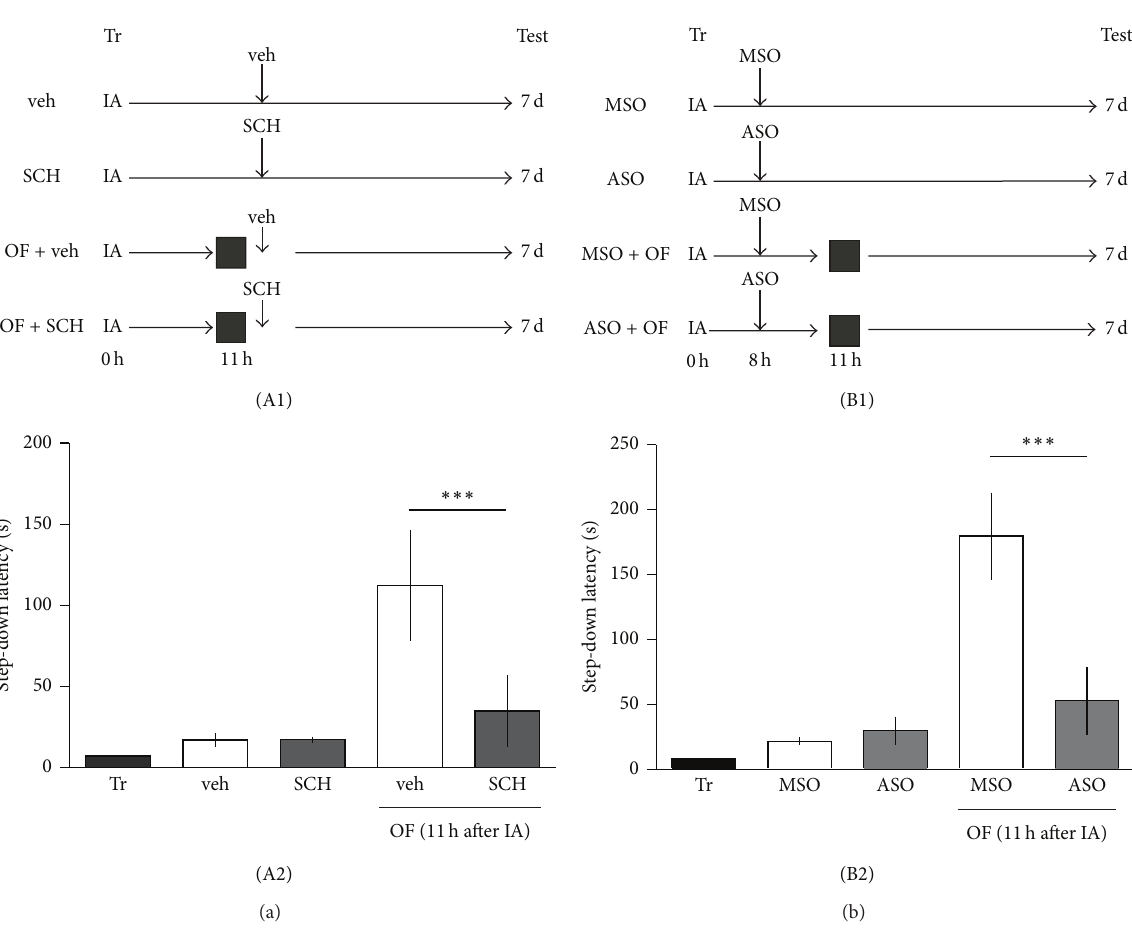
Figure 4: The effect of novelty on the promotion of memory persistence requires dopamine D1/D5 receptors and Arc expression in the dorsal hippocampus.(A1,B1)Schematicrepresentationoftheexperimentalprotocolispresentedonthetopofeachpanel.(A2)Animalsweretrained in the IA and exposed to an OF 11h later. Shortly after exploration, rats were CA1 infused with SCH 23390 (1.5 𝜇 g/1 𝜇 L per side) or veh. Two other groups of rats were infused with veh or SCH in the absence of OF. Test was performed 7 days after training. (B2) Animals were trained in the IA and 8h after training they were CA1 infused with antisense (ASO) or missense (MSO) oligonucleotide of arc . 3 h later they were exposed to an OF. Two other groups of rats were infused with MSO or ASO in the absence of OF. Test was performed 7 days after training. Data are presented as mean ±